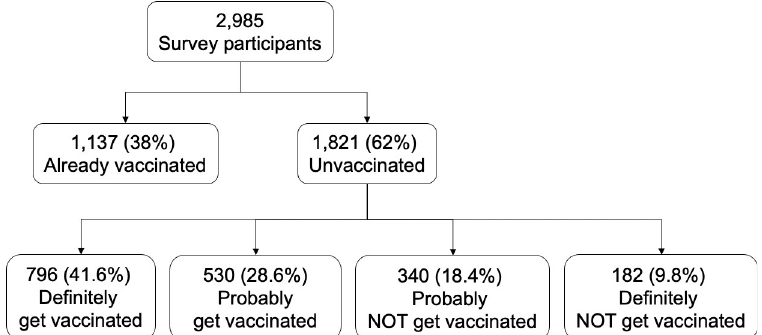
Fig 1. Survey flow diagram for analysis sample. Numbers are unweighted. Survey was delivered between March 15 to March 22, 2021.